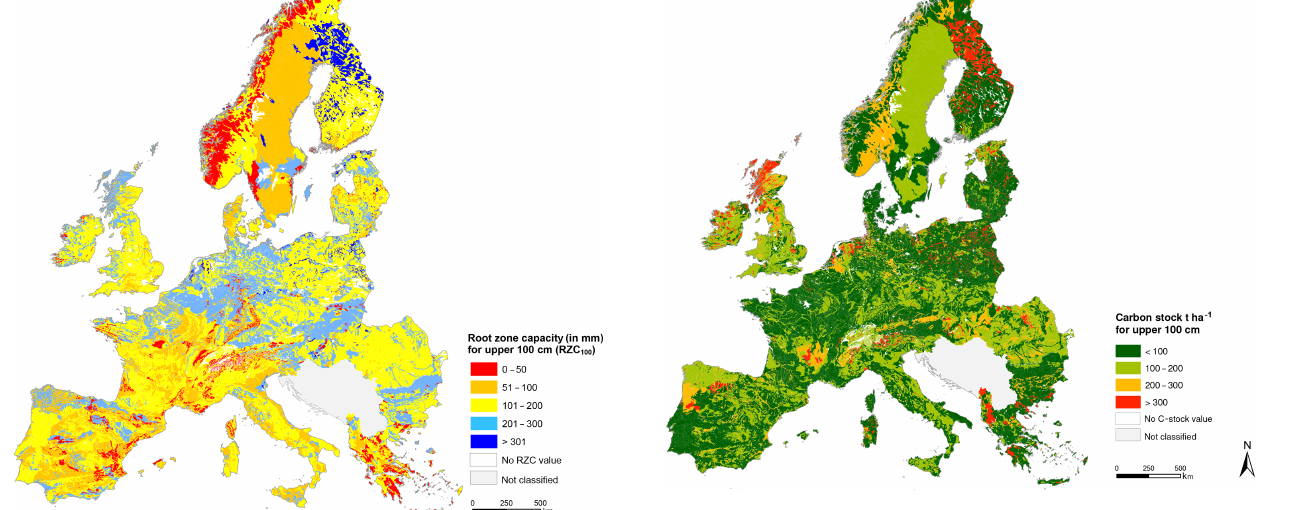
Figure 2. Plant available water content (in mm) within the up- permost 1m of the soil: very low – 0–50mm, low – 50–100mm, medium – 100–200mm, high – 200–300mm – and very high – > 300.